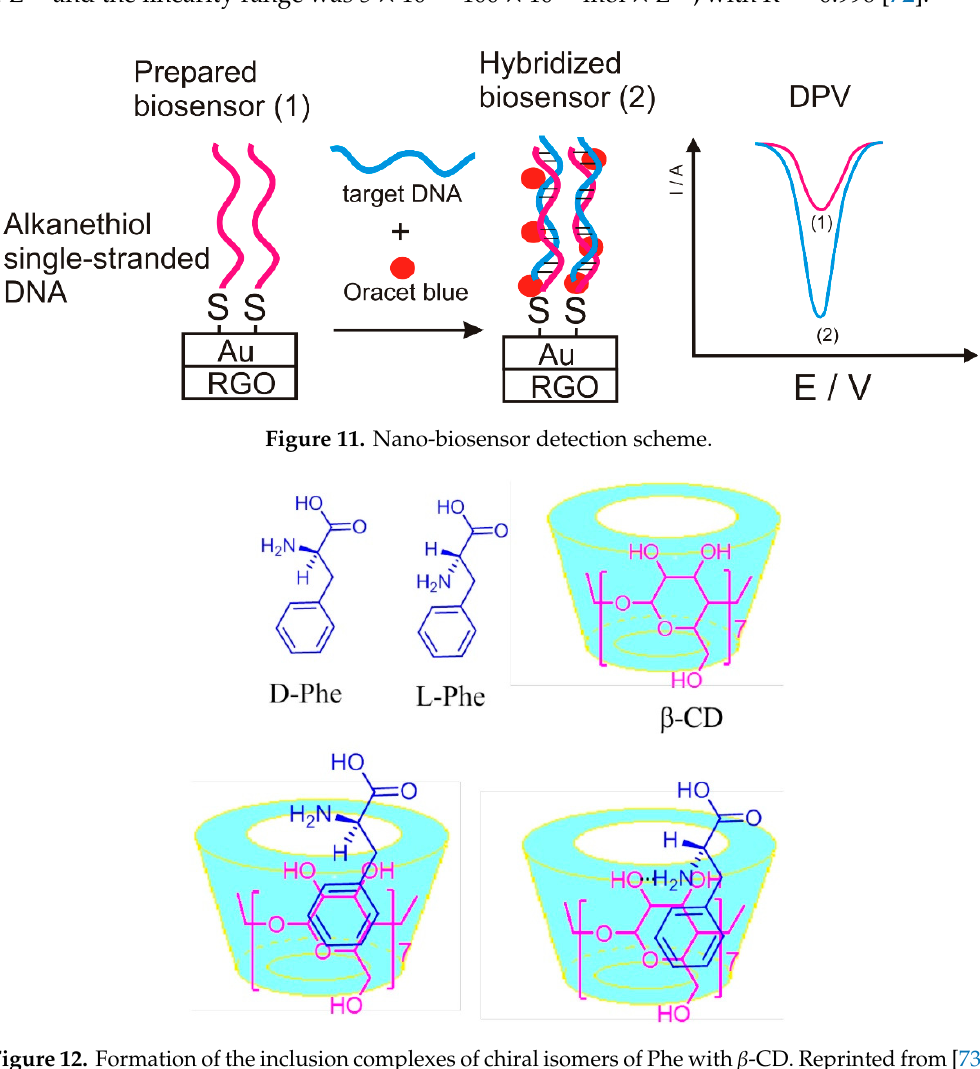
Figure 12. Formation of the inclusion complexes of chiral isomers of Phe with β -CD. Reprinted from [73] Figure 11. Formation of the inclusion complexes of chiral isomers of Phe with β ‐ CD. Reprinted from with permission of [73] with permission of publisher.